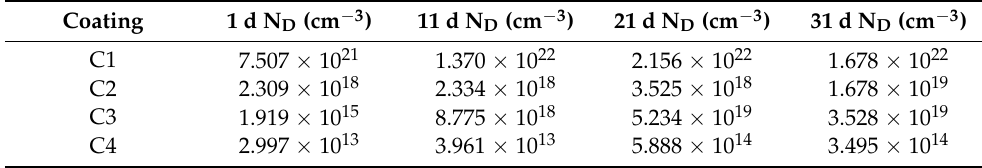
Table 4. Carrier density after immersion for 1 d, 11 d, 21 d, and 31 d.